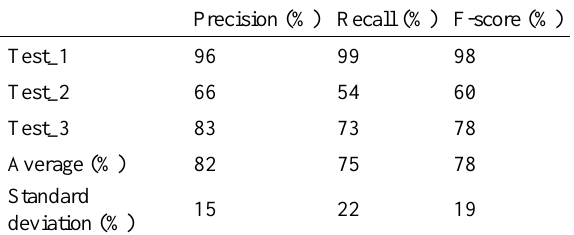
Table 1. Precision, recall and F-score results for each case